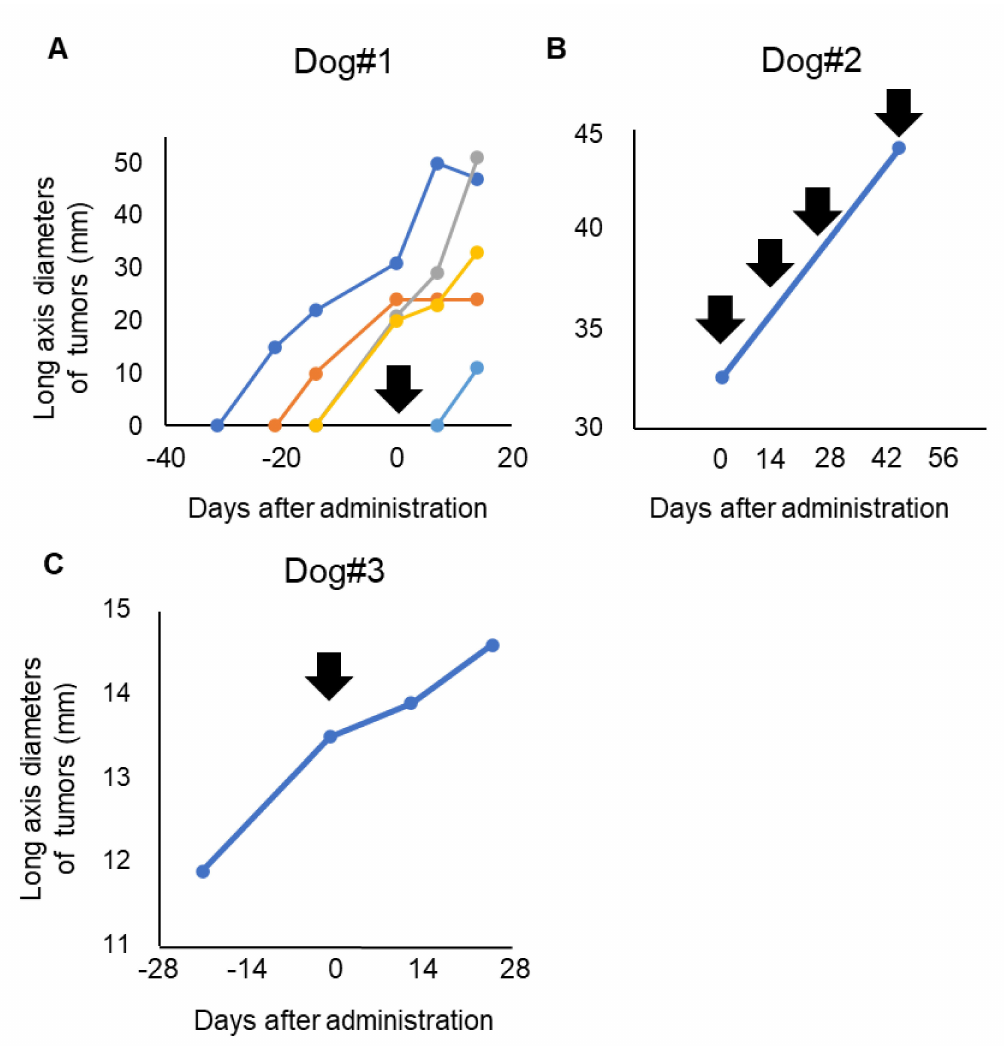
Figure 3. Evaluation of P38Bf e ffi ciency in the clinical trial. Measurement and evaluation of the skin metastasis of Dog #1 ( A ), the oral primary tumor of Dog#2 ( B ), and the oral primary tumor of Dog#3 ( C ). The tumor burden of Dog#1, Dog#2, and Dog#3 was evaluated by measuring the diameter of the long axis. The day of first antibody administration is shown as Day 0, and black arrows indicate the timing of P38Bf